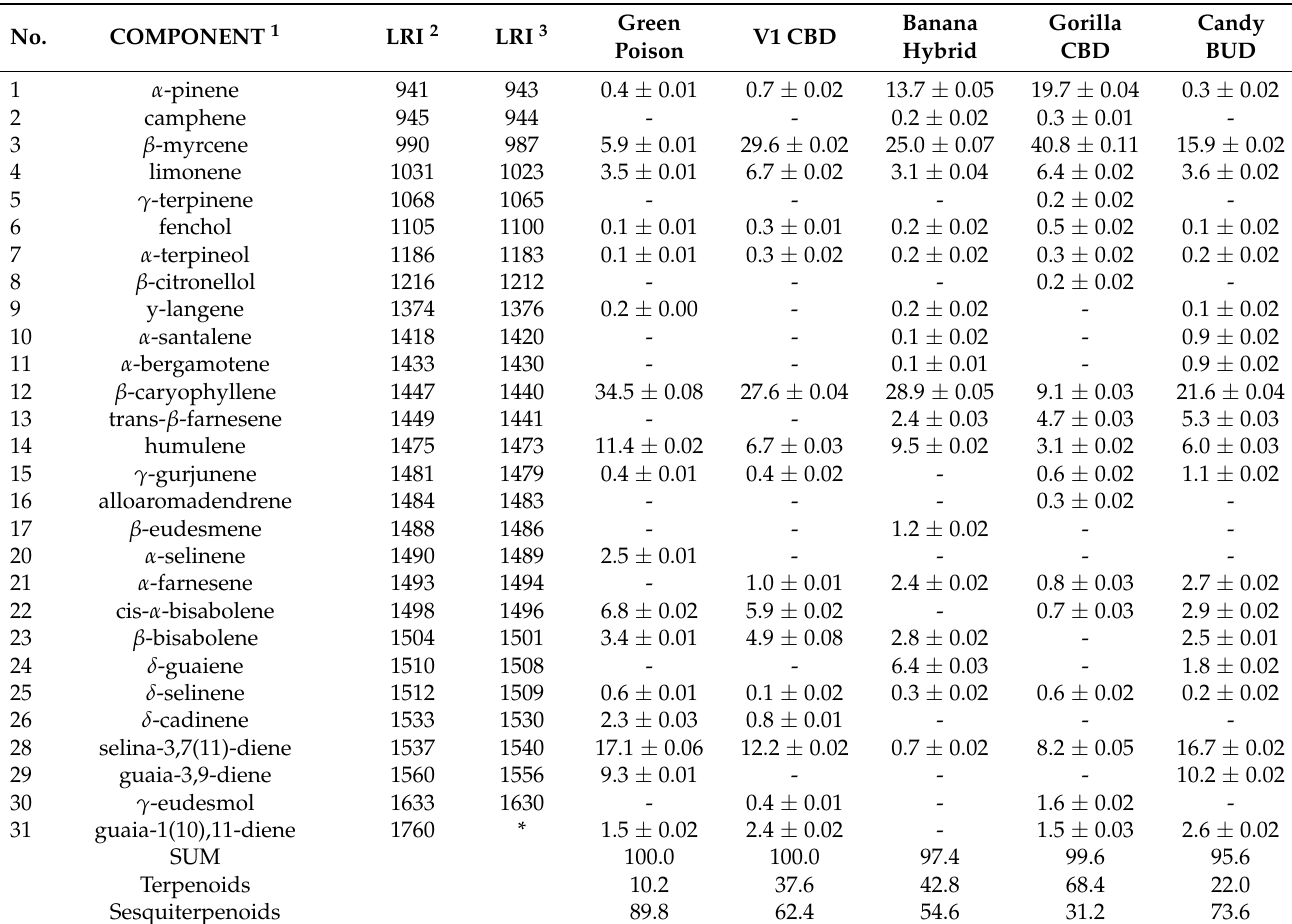
Table 1. Chemical volatile composition (percentage mean value ± standard deviation) of Cannabis sativa L. inflorescences.